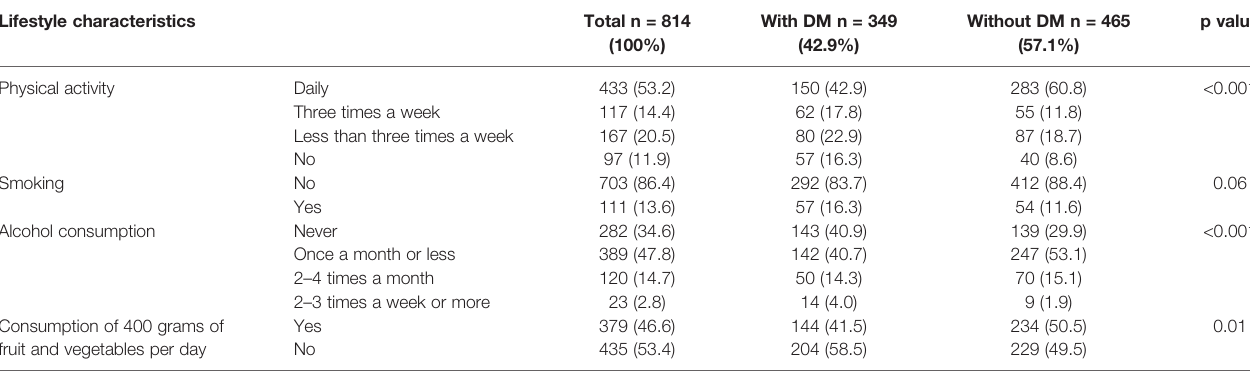
TABLE 1 | Lifestyle characteristics among the respondents. Lifestyle characteristics